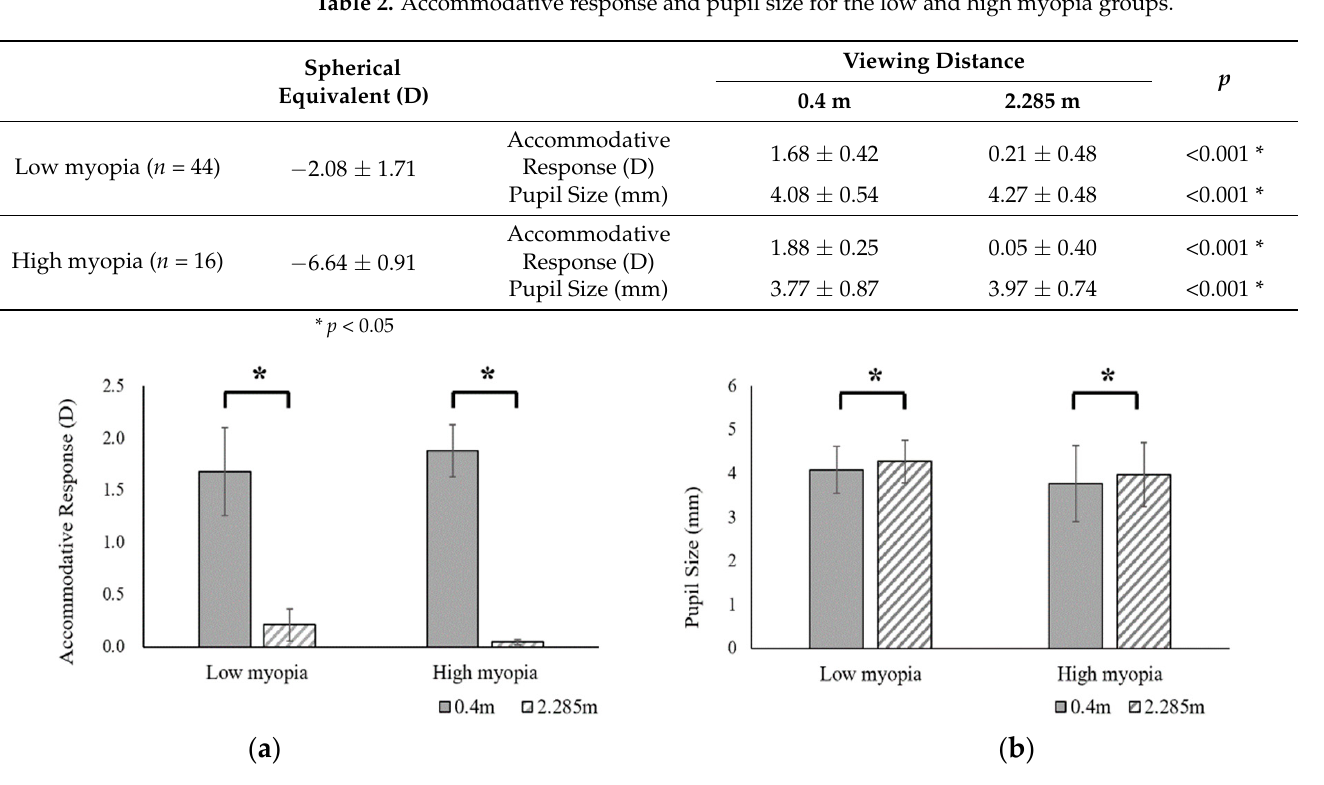
Figure 4. ( a ) Mean accommodative response; ( b ) Mean pupil sizes for the low and high myopia groups. (* p <